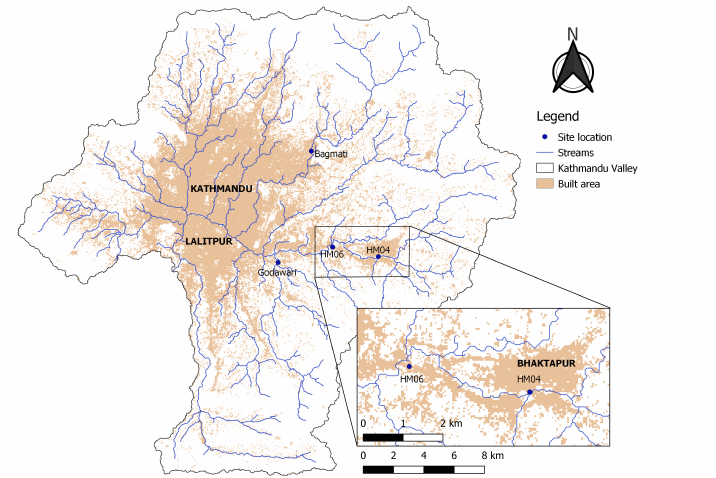
Figure 1. Overview of the Kathmandu Valley and Bhaktapur. HM04 and HM06 have been used in the calibration